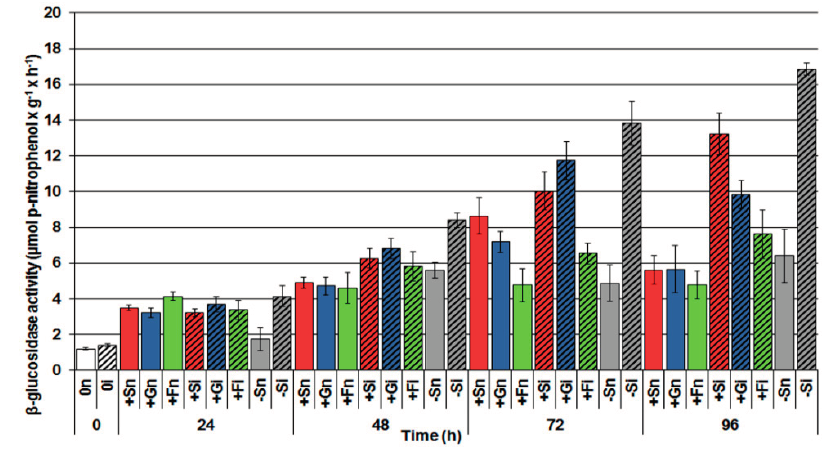
Figure 4. The effect of sucrose, glucose and fructose on β -glucosidase activity in in vitro cultured embryo axes of L. luteus infected with F. oxysporum . Statistical significance of differences between the average values of each pairs for β -glucosidase activity. Statistically significant differences ( p -value) was assumed at p <